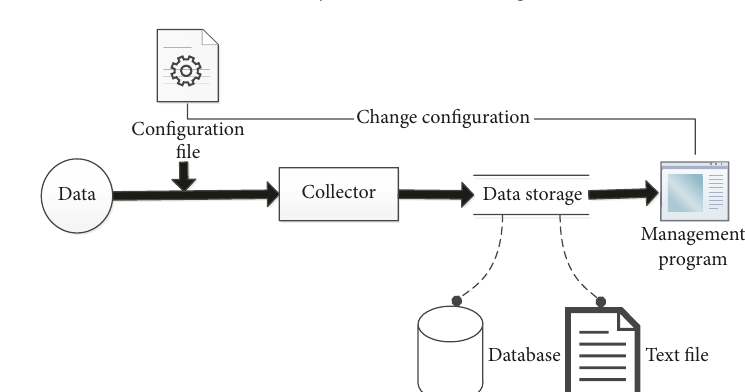
Figure 2: Log subsystem structure